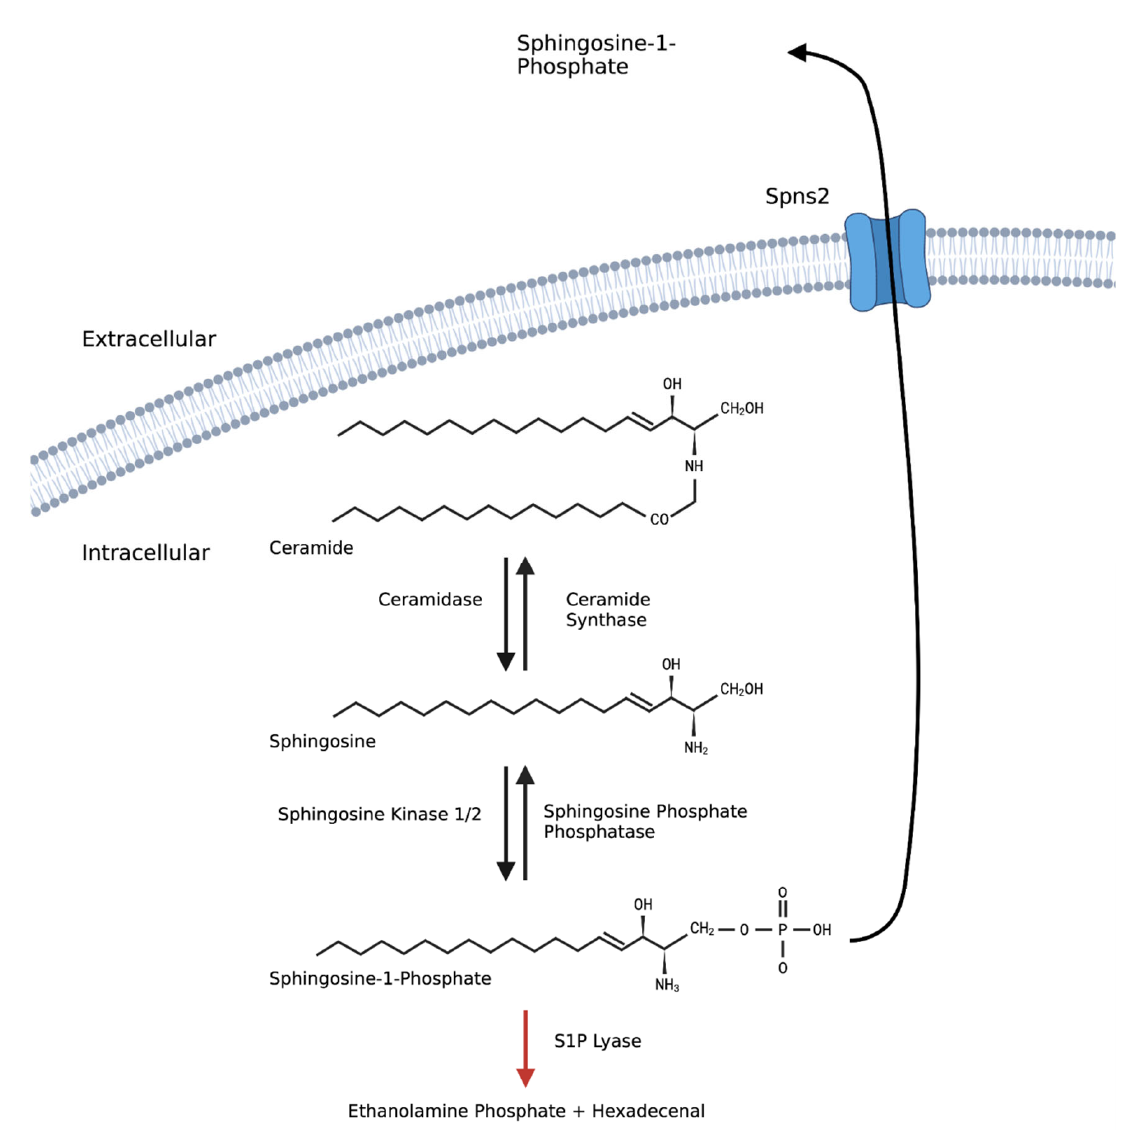
Figure 1. Sphingosine metabolic pathway. Ceramide, sphingosine, and sphingosine-1-phosphate can be metabolised into each other via various enzymes. Ceramide is converted into sphingosine through a reversible reaction by ceramidase (CDase) and ceramide synthase (CerS) [18]. Sphingosine frequently converted to sphingosine-1-phosphate via the two sphingosine kinases (SPHK1/2) [19]. S1P is metabolised back to sphingosine via sphingosine phosphate phosphatases (SPPase) or by an irreversible reaction by S1P lyase [19]. S1P is then exported out of the cell via spinster 2 (SPNS2). Created in